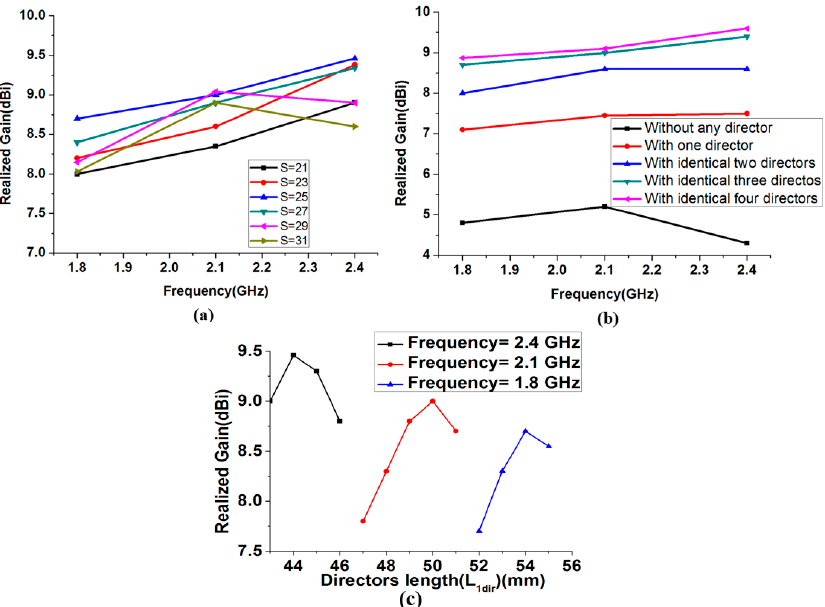
Figure 3. ( a ) Simulated realized peak gain for different S. ( b ) Simulated realized peak gain for all frequency bands for the different number of directors. ( c ) Simulated peak gain for different lengths of directors (L 1dir ) at 1.8 GHz, 2.1 GHz, and 2.4 GHz.